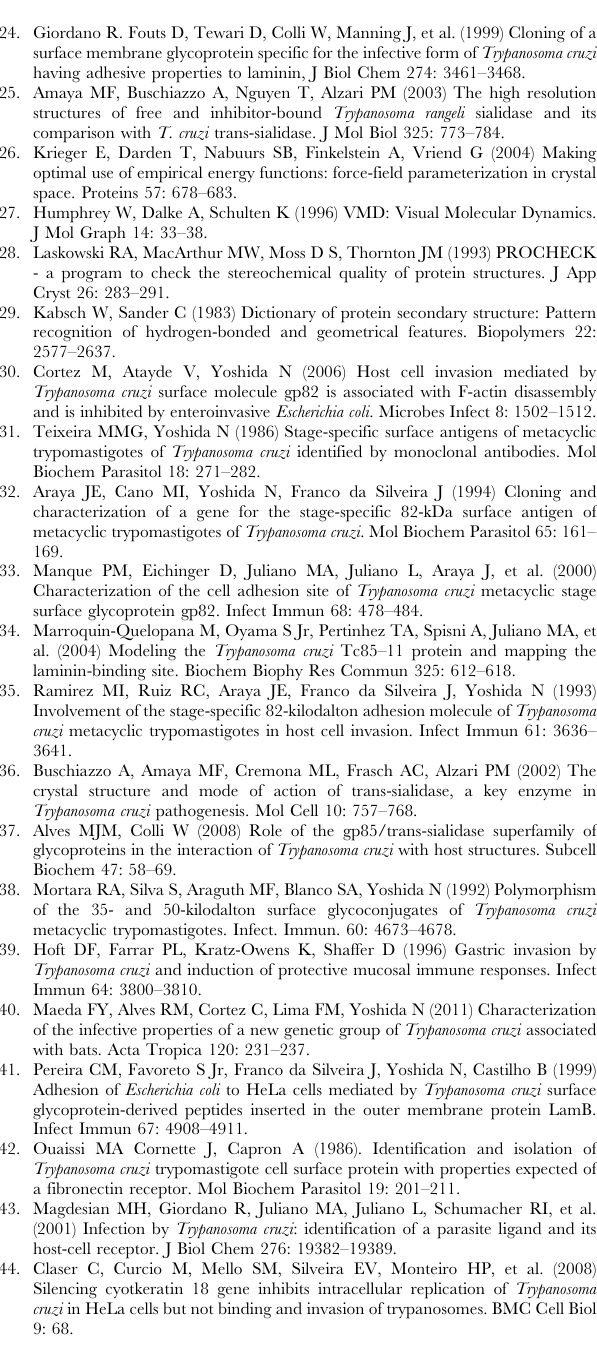
Figure S1 The a -carbon Root Mean Square Deviation from the gp82 model plotted as a function of simulation time. A small oscillation was observed during the first 15 ns and after that the model became stable. (TIF) Figure S2 Reaction of T. cruzi metacyclic trypomasti- gotes with mAb 3F6. Live parasites were incubated with mAb 3F6 and processed for visualization at fluorescence microscope. (TIF)